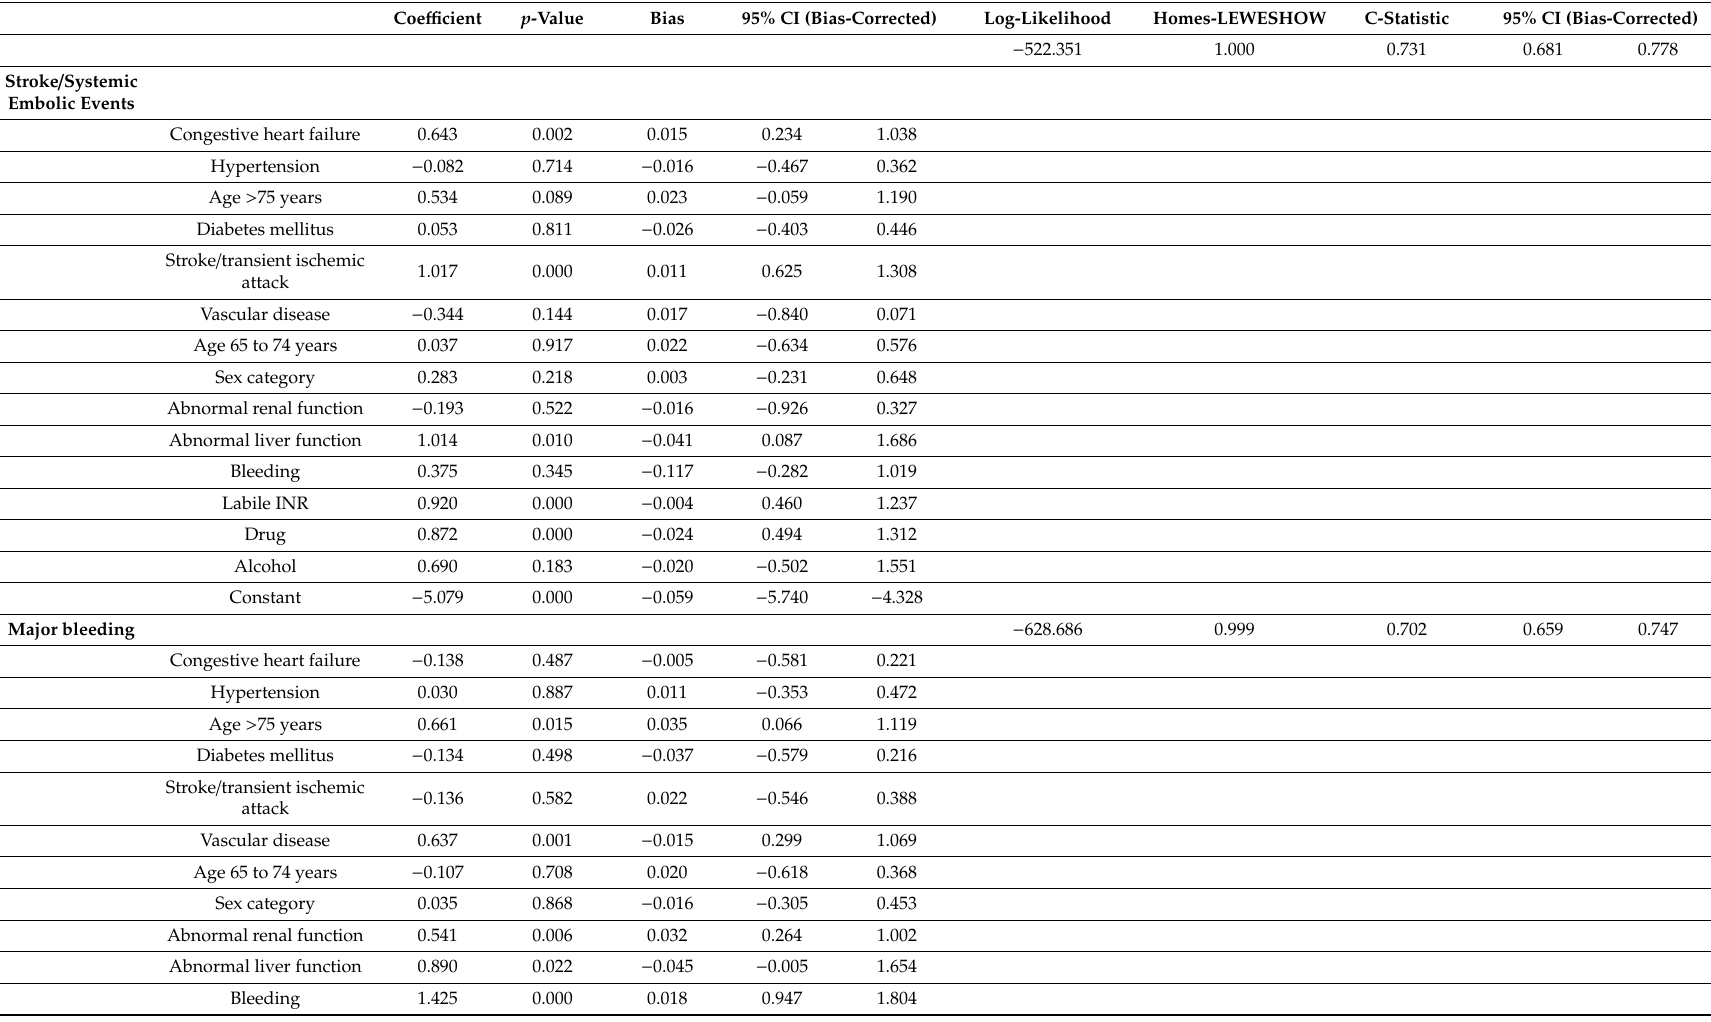
Table 2. Logit regression results with CHA2DS2-VASc and HAS-BLED